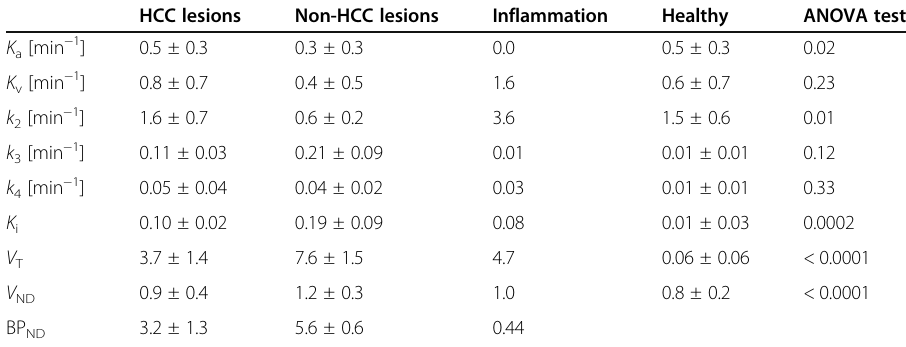
Table 2 Results for the relevant obtained model parameters of model AV for all lesions and healthy regions. The p value for the ANOVA test for all four groups is also given, results < 0.01 are underlined. Values are presented as mean value plus-minus one standard deviation. Note BP NP is n presented for healthy regions since k 3 and k 4 were zero or almost zero HCC lesions Non-HCC lesions Inflammation Healthy ANOVA test − 1 K a [min